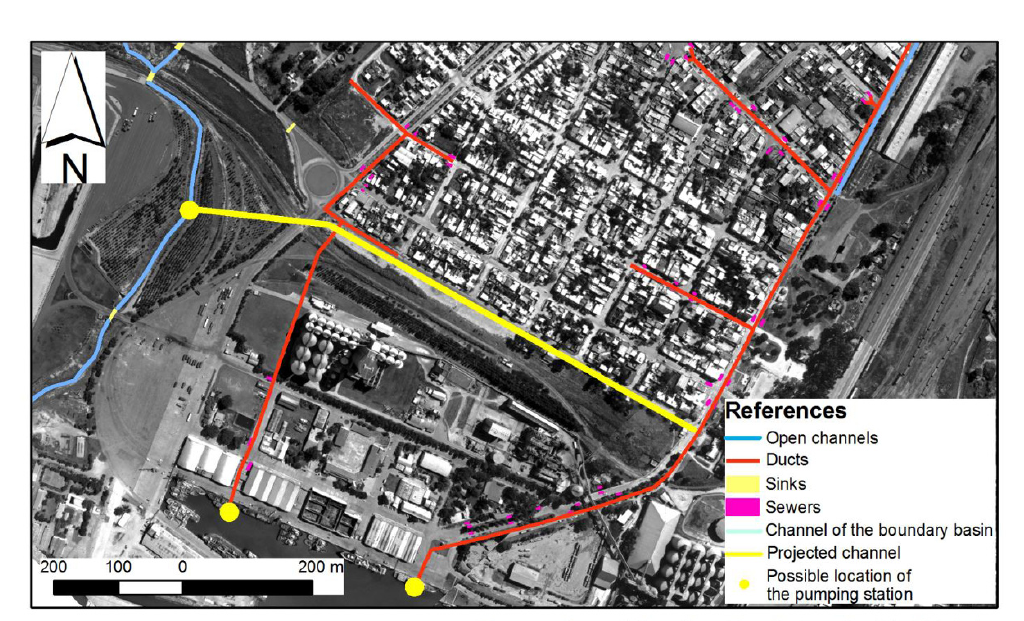
Figure 8. Enlarged detail of Figure